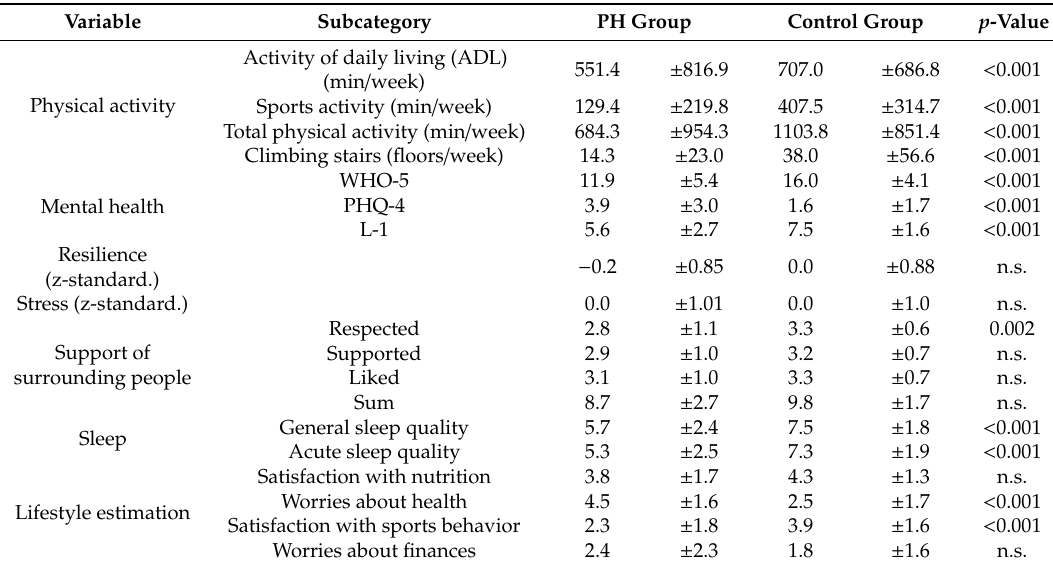
Table 2. Characteristics and group di ff erences of subjects of the PH and control